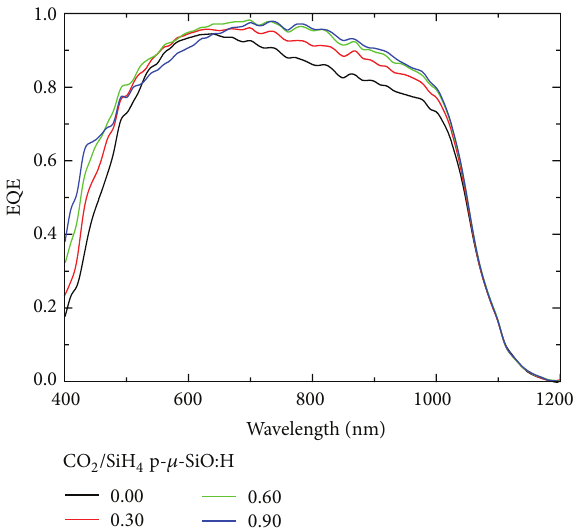
Figure 6: EQE of c-Si-HJ solar cells with various CO 2 /SiH 4 ratios for the p- 𝜇 c-SiO:H layer.